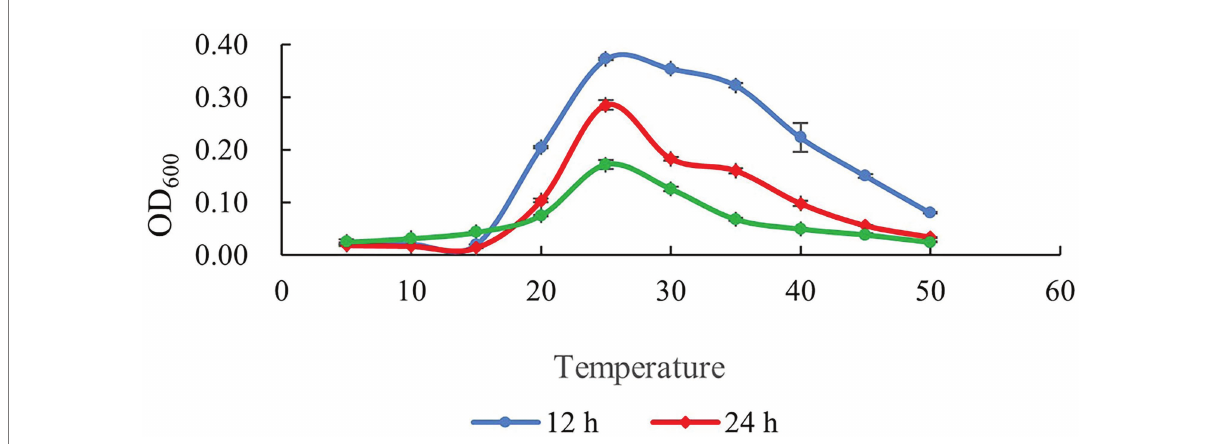
FIGURE 2 Determination of growth temperature of SDTB038. Blue: growth curve of SDTB038 cultured for 12 h; Red: growth curve of SDTB038 cultured for 24 h; Green: growth curve of SDTB038 cultured for 48